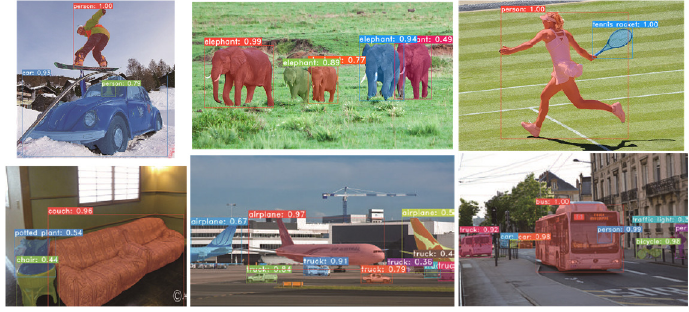
Figure 10. Some examples of object detection results [27].